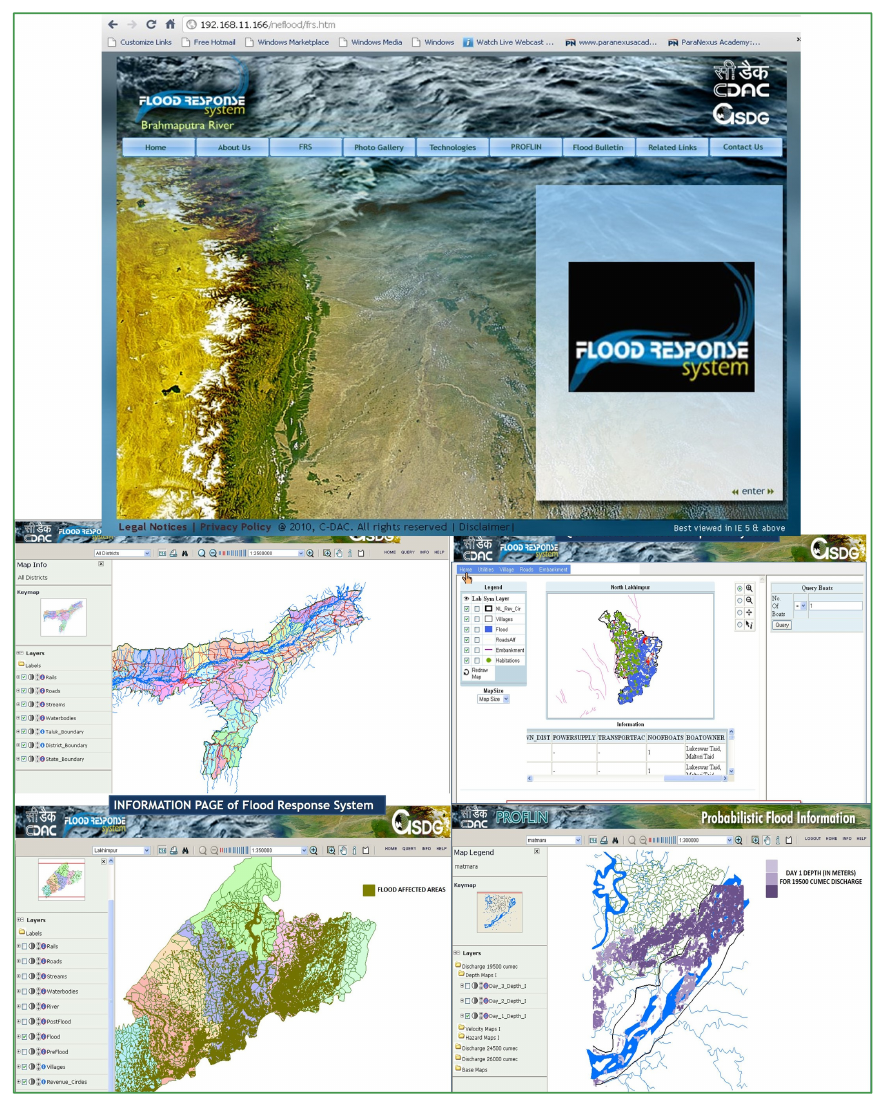
Figure 5. Snapshots of Flood Response System.